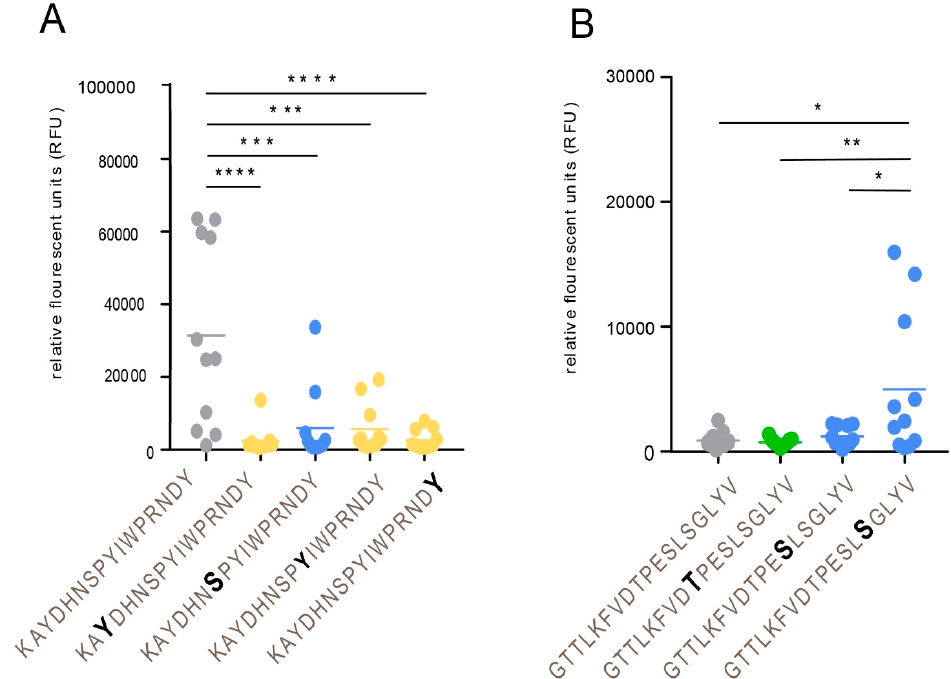
Figure 4. Addition of a GalNAc residue to a peptide epitope: effects on antibody binding. ( A ) Interference with antibody binding. ( B ) Enhancement of antibody binding. Individual serum samples from VZV-positive patients (n = 11) were analyzed. Addition of a GalNAc residue is indicated by bold letters. Statistic calculations were done using one-way ANOVA with Tukey´s multiple comparisons test (significance is indicated by * p -values < 0.05, ** p -values < 0.01, *** p -values < 0.001, and **** p -values < 0.0001).